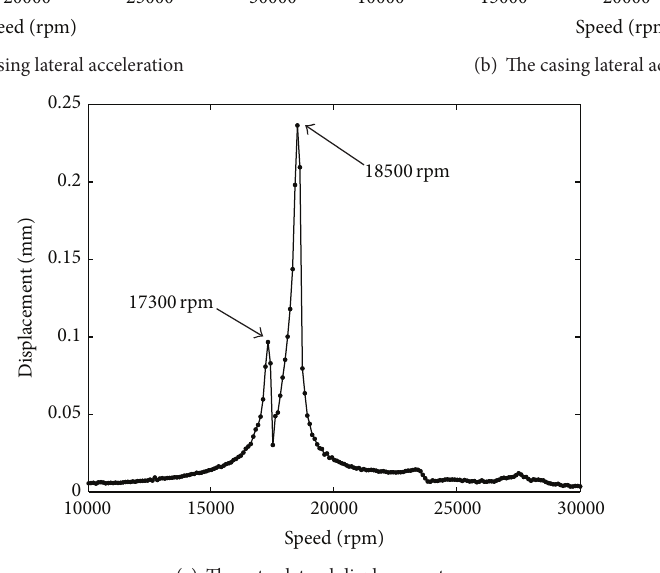
shows cascade plot of the bearing housing 𝑆 1 lateral accel- eration response at different speeds; Figure 7 shows cascade plot of the casing lateral acceleration response at the ninth node at different speeds; Figure 8 shows cascade plot of the compressor rotor lateral displacement at the first node at